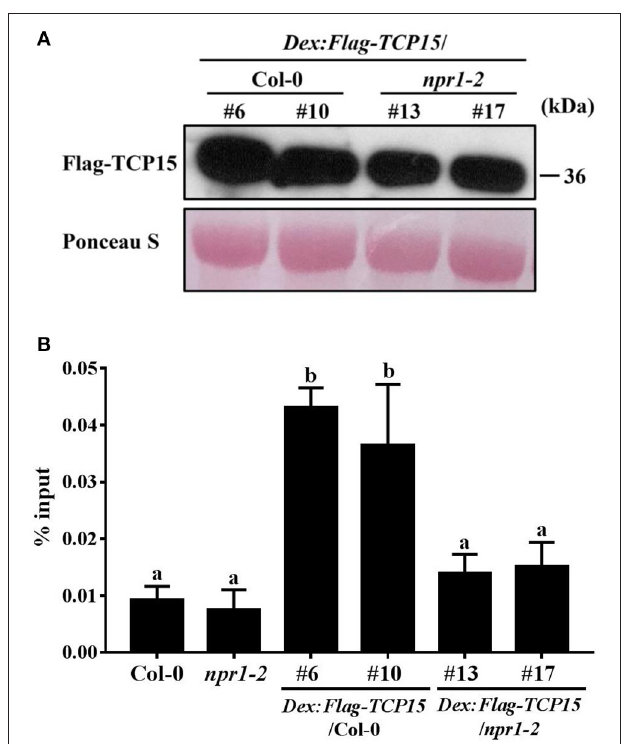
FIGURE 5 | NPR1 enhances TCP15 binding to the PR5 promoter. (A) FLAG-TCP15 protein levels in DEX inducible transgenic lines. Twelve-day-old seedlings of T3 homozygous lines expressing FLAG-TCP15 under the control of a DEX-inducible promoter in the Col-0 and npr1-2 background ( DEX:FLAG-TCP15 / npr1-2 ) were treated with 30 µ M DEX for 24h. Protein levels were measured by immunoblot with the anti-FLAG antibody. (B) The binding ability of TCP15 to the PR5 promoter in transgenic plants described in (A) were examined with ChIP assays combined with RT-PCR analysis. Twelve-day-old seedlings were treated with 30 µ M DEX, then treated with 0.5mM SA after 24h. Samples were collected 24h after SA treatment. Primers amplifying fragment b described in Figure 3B were used in RT-PCR. The enrichment of PR5 promoter DNA in immunoprecipitated samples was shown as % input. Error bars represent SD of three technical replicates. Statistical analysis was studied by two-way ANOVA following multiple comparisons with turkey test (95% confidence interval) using GraphPad Prism 7. Different small letters above the bars mean significant differences. Another independent replication demonstrated similar